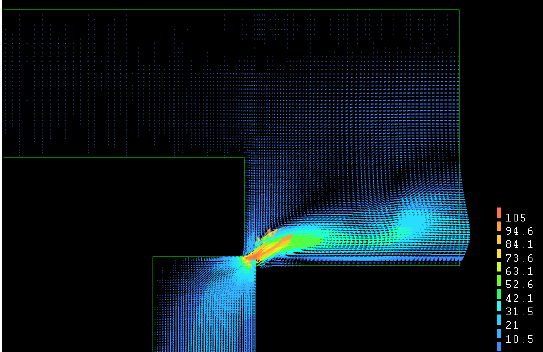
Fig. 10. Outcoming airflow in the plan when the upper edge of the side electrode is lower than the below edge of the side electrode Four locations corresponding to different relative heights of the central and side electrodes were modelled to investigate their effect on the air jet directions. The velocity vectors are shown in Figs 7 through